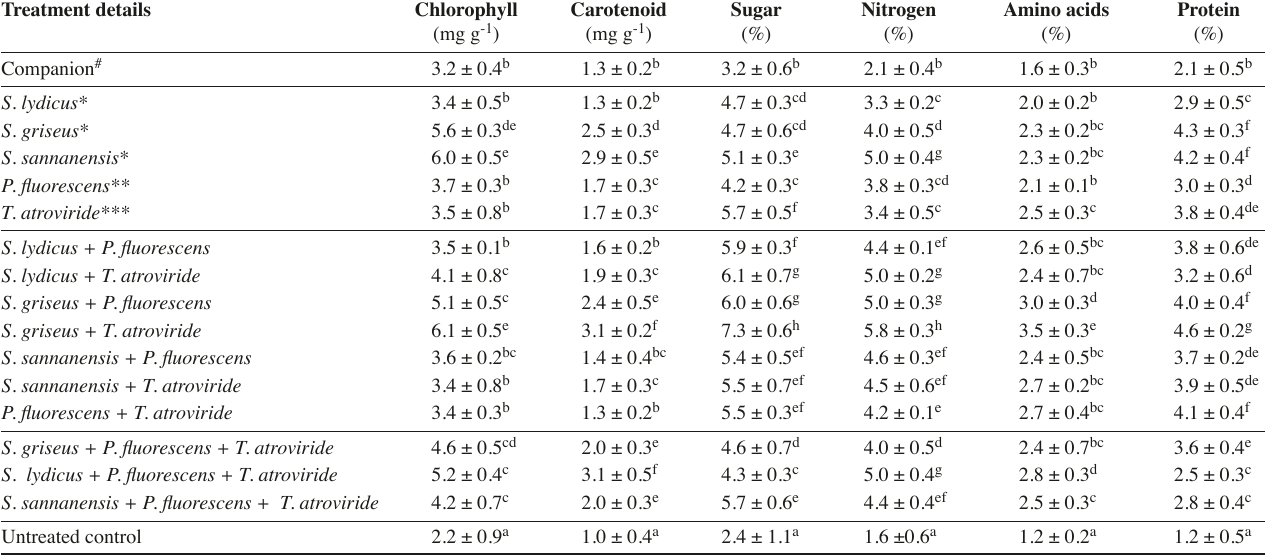
Tab. 5: Effect of various biocontrol agents and fungicide on biochemical constituents in rhizome rot disease infected turmeric plant leaves Treatment